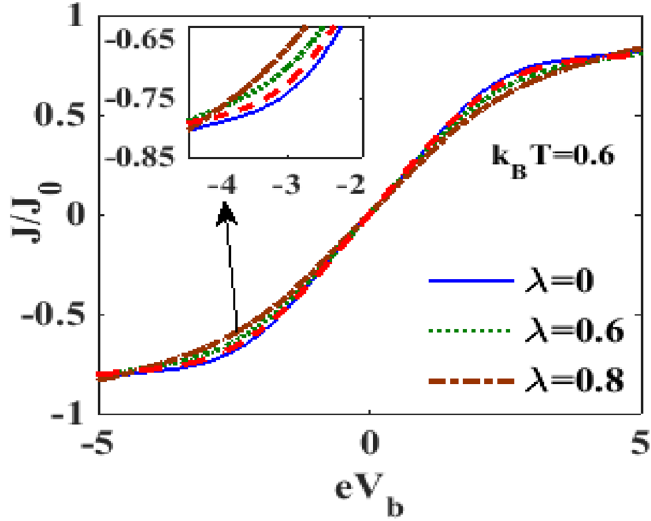
Figure 7. J / J 0 versus eV b for different values of (cid:31) at eV m = 0.5, γ = 0.02, k B T = 0.6 .